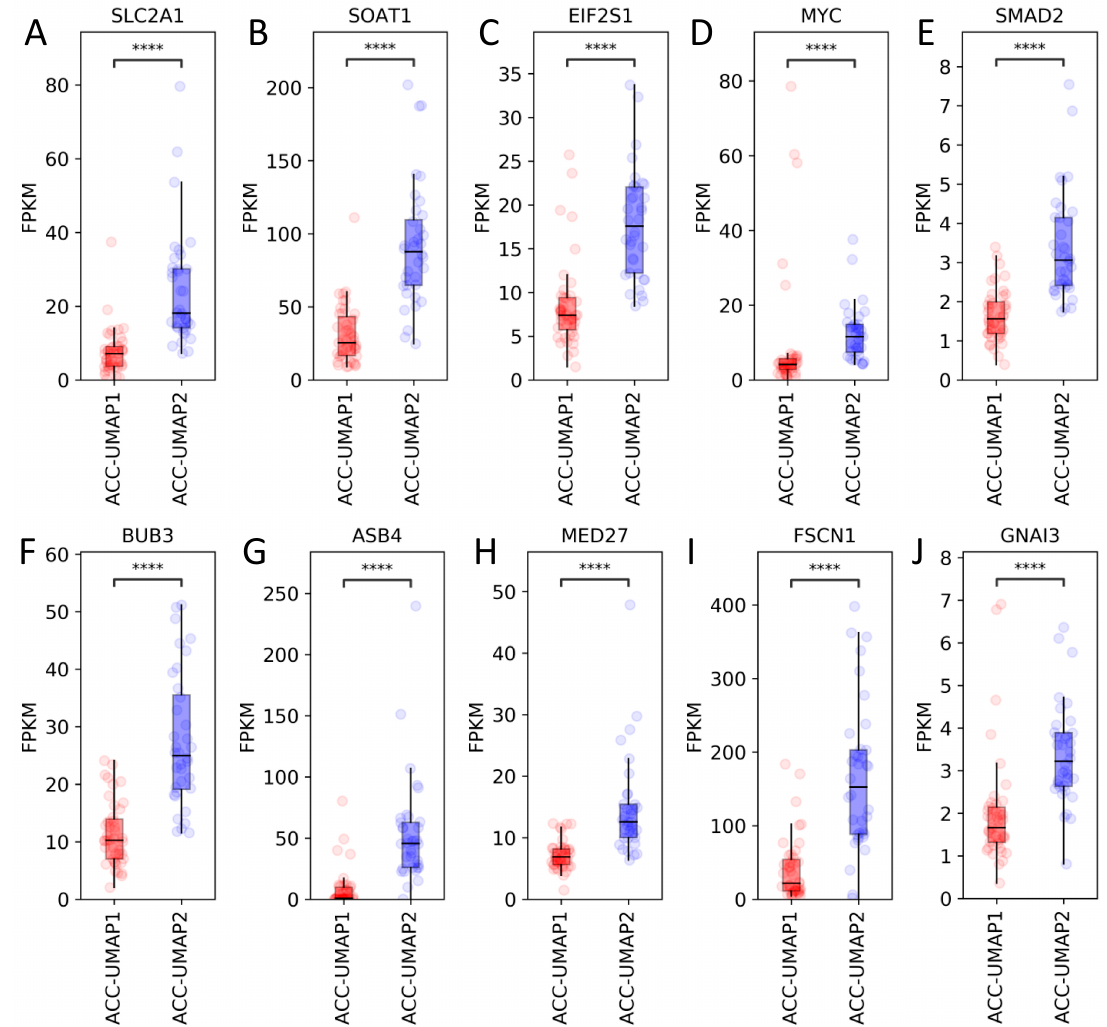
Figure 2. Selection of mRNA expression pattern of 10 genes from the TCGA-ACC dataset, as identified by RF analysis, that were previously shown to be involved in adrenal function. SLC2A1 : solute carrier family 2 member 1 ( A ), SOAT1 : sterol-O acyltransferase ( B ), EIF2S1: eukaryotic translation initiation factor 2 α ( C ), MYC proto-oncogene MYC ( D ), SMAD2: sma—and mad-related protein 2 ( E ), BUB3 budding uninhibited by benzimidazoles 3 homolog ( F ), ASB4: ankyrin repeat And SOCS box containing 4 ( G ), MED27 : mediator complex subunit 27 ( H ), FSCN1 : fascin actin-bundling protein 1 ( I ), GNAI3: guanine nucleotide binding protein (G protein), alpha inhibiting activity polypeptide 3 ( J ) . ns, not significant. **** p < 0.0001. Y -axis units: FPKM.